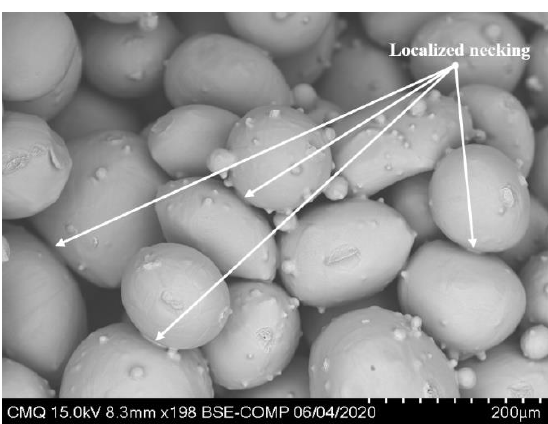
Figure 4. SEM micrographs of the Ti-6Al-4V spherical powder after the initial heating.